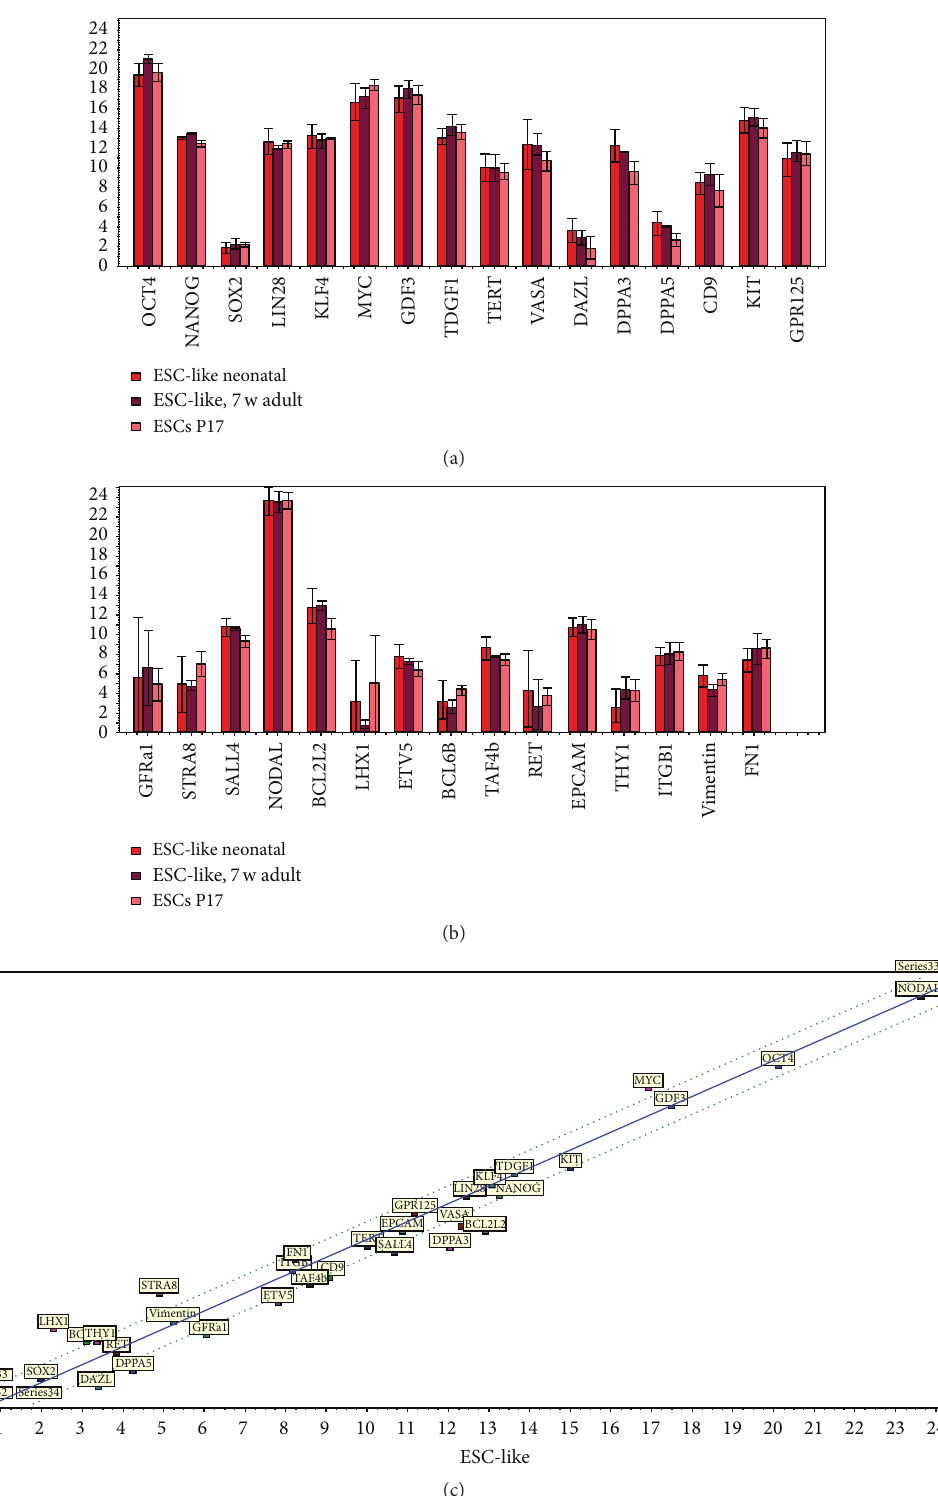
Figure 8: Bar plot showing expression of pluripotency and germ cell associated genes between ESC-like cells (coloured pink or dark red) and mESCs (coloured light red). Note that the core pluripotency genes Oct4, Nanog, and Sox2 are not differentially regulated between ESC-like cells and